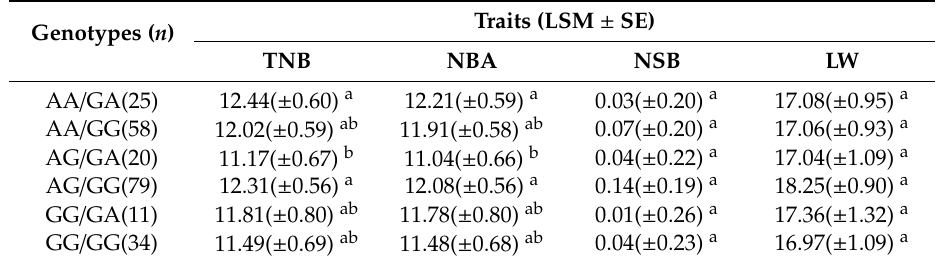
Figure 5. Genotype frequencies of the mutations BMP7 c.1569A>G and BMP15 c.2366G>A in Large White pig population. n = 227. Table 4. Combination e ff ect of the genotypes formed by BMP7 c.1569A > G and BMP15 c.2366G > A on reproductive